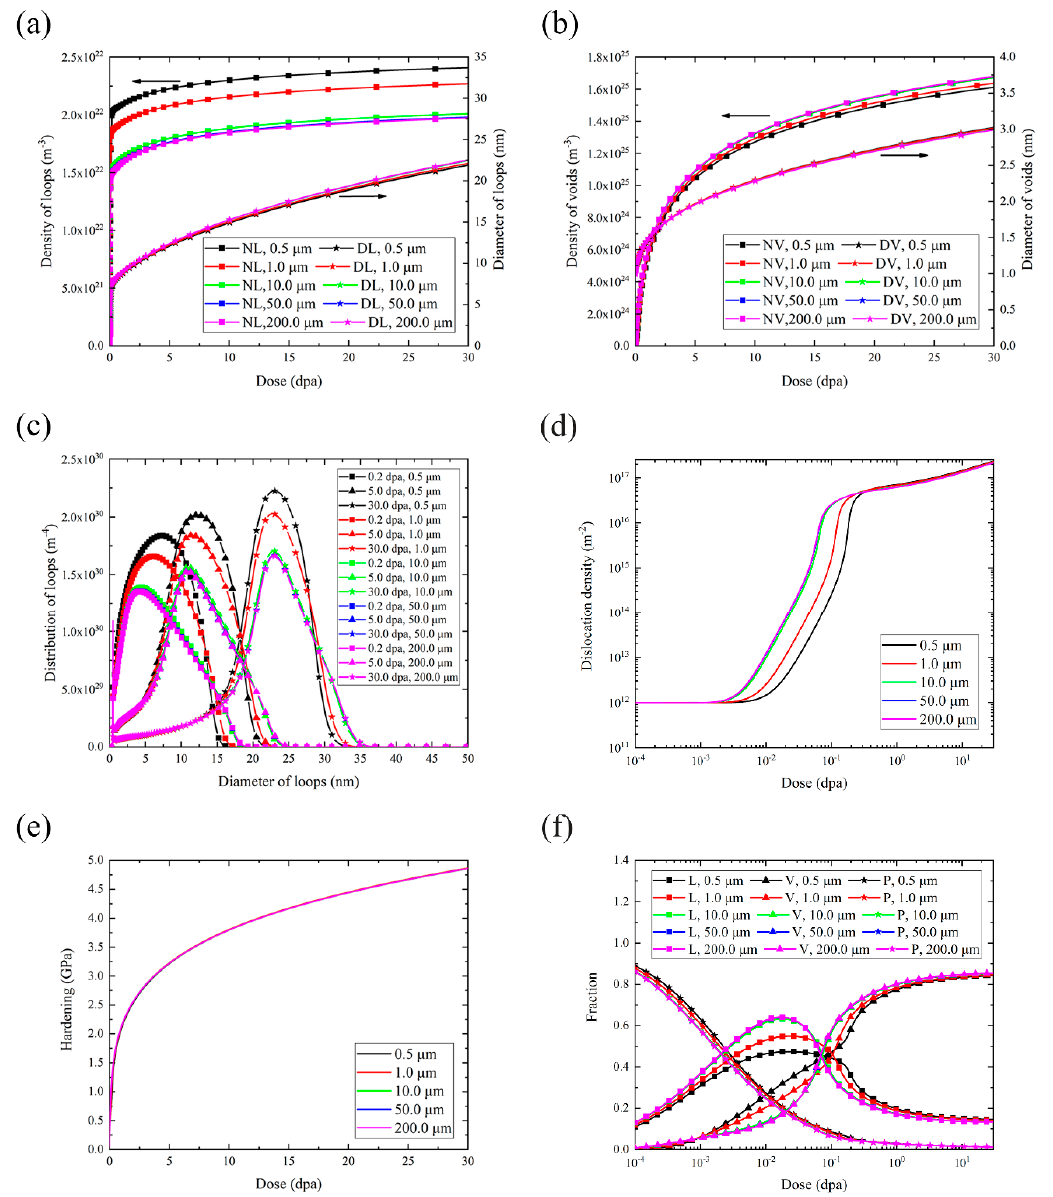
Figure 2. Rate theory simulation results with various grain sizes. ( a ) Number density and diameter of loops. ( b ) Number density and diameter of voids. ( c ) Distribution of loops at 0.2 dpa, 5 dpa and 30 dpa. ( d ) Dislocation density. ( e ) Hardening. ( f ) Contribution of loops (L), voids (V) and precipitates